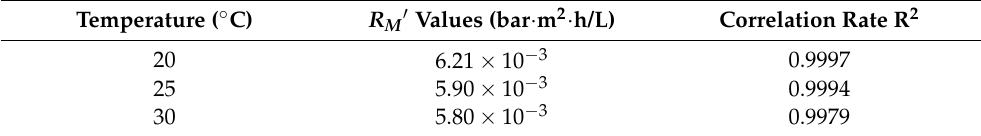
Table 3. Intrinsic resistance values of the ultrafiltration membrane at different temperatures.